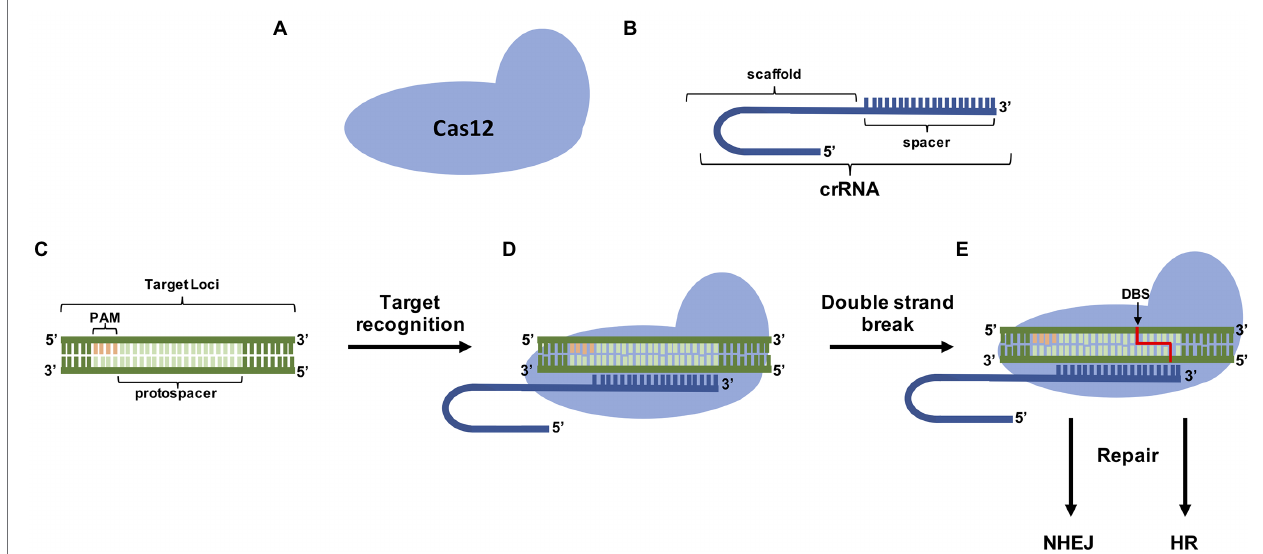
FIGURE 4 | CRISPR/Cas12a genome editing components. (A) The Cas12a protein capable of provoking double-strand breaks (DSBs) in specific target sites with the help of (B) the CRISPR RNA (crRNA) that contains the sequence (spacer; C ) complementary to the target 3 ′ from the Protospacer Adjacent Motif (PAM) site. (D) The ribonucleoprotein complex leads to specific DSB located generally cleaves DNA 18–23 nt distal of the PAM via 5 bp staggered double-stranded breaks. (E) Repair mechanisms (NHEJ and HR) fix